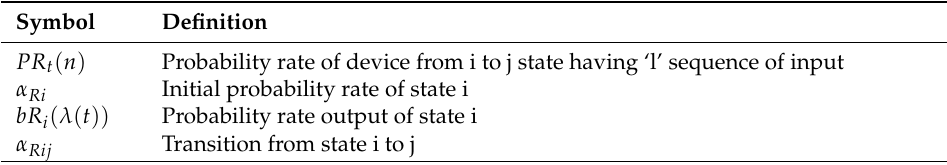
Table 2. Notations of Viterbi